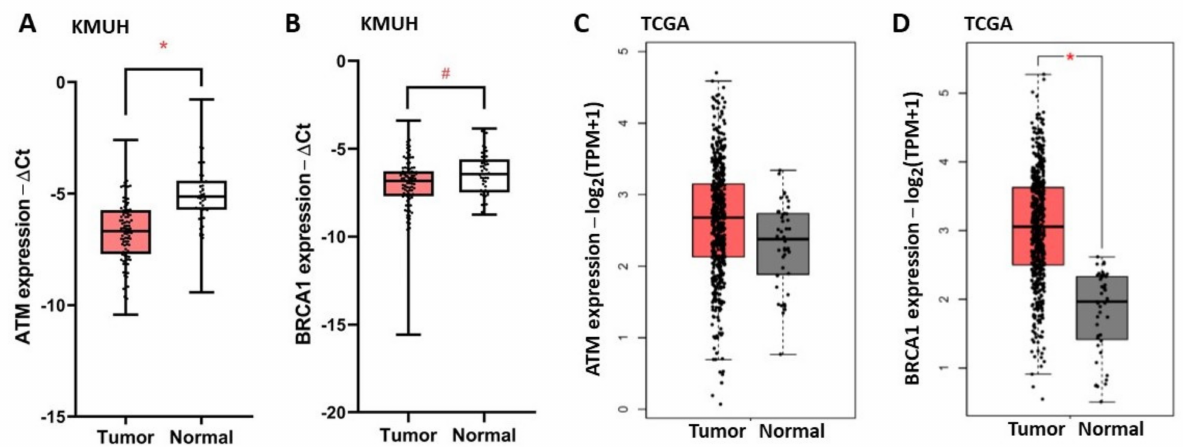
Figure 2. The expressions of ATM and BRCA1 mRNA are downregulated in BQ-associated HNC. ( A , B ) The relative expression of ATM ( A ) and BRCA1 ( B ) mRNAs in HNC ( n = 100) versus adjacent non-tumor (normal) tissues ( n = 52) of the Kaohsiung Medical University Hospital (KMUH) cohort were shown as box plots. ( C , D ) The expression of ATM ( C ) and BRCA1 ( D ) mRNAs in HNC ( n = 519) and in adjacent normal tissues ( n = 44) of The Cancer Genome Atlas (TCGA) cohort were shown as box plots. TPM, transcripts per million. # p < 0.05; * p < 0.01 (Mann-Whitney U